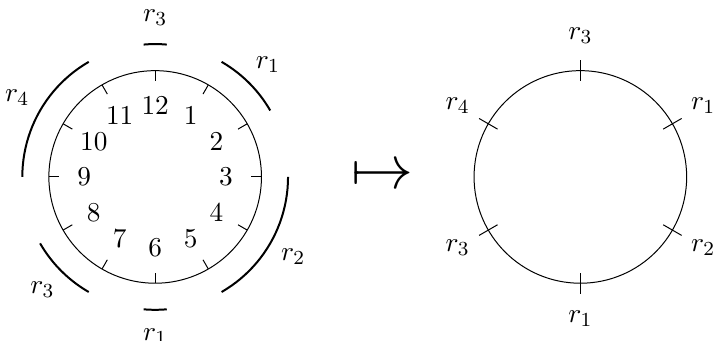
Figure 6. The left graph depicts an example partition of the integers f 1 ; : : : ; 12 g into four weakly separated subsets. As the positivity requirement imposes the same conditions on consecutive numbers in the same subset, all of the positivity properties of a partition are contained in its reduced graph, an example of which is depicted on the